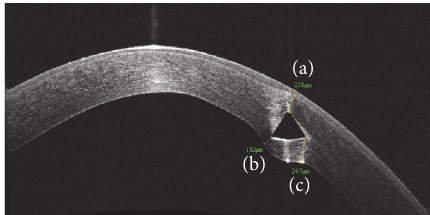
Figure 3: The segments traced to measure the distance from the apex to the anterior corneal surface (a) and the distance from the inner (b) and the outer (c) basal corners to the posterior corneal